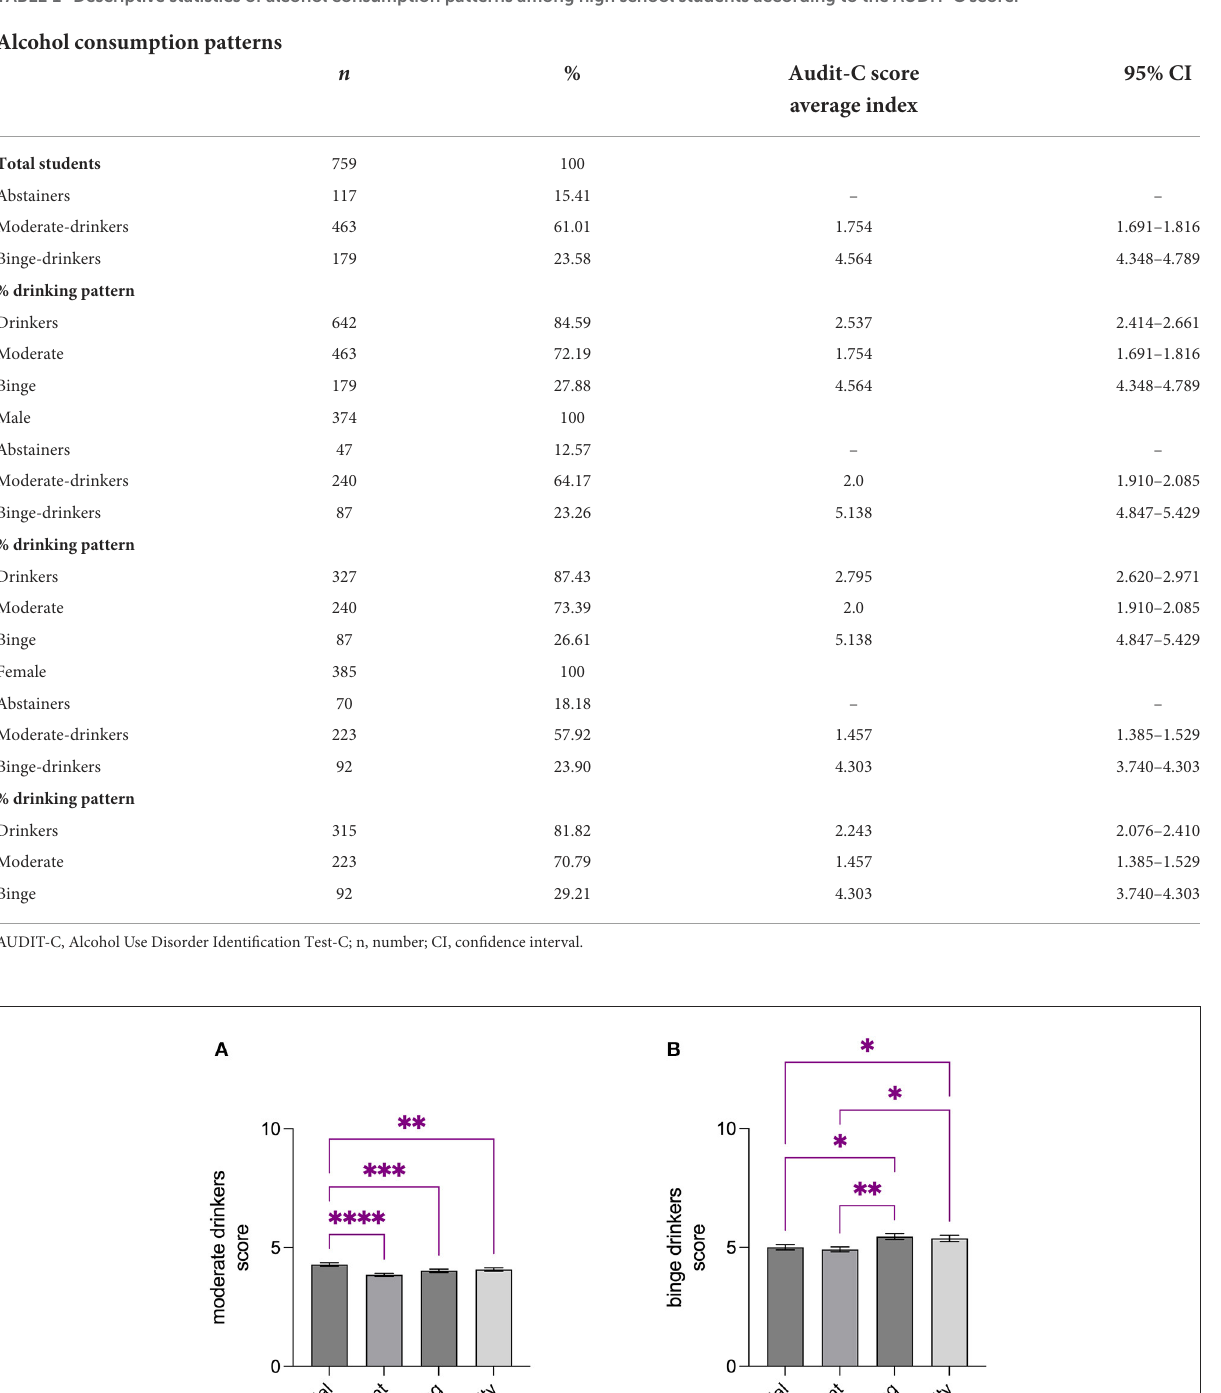
TABLE 1 Descriptive statistics of alcohol consumption patterns among high school students according to the AUDIT-C score.